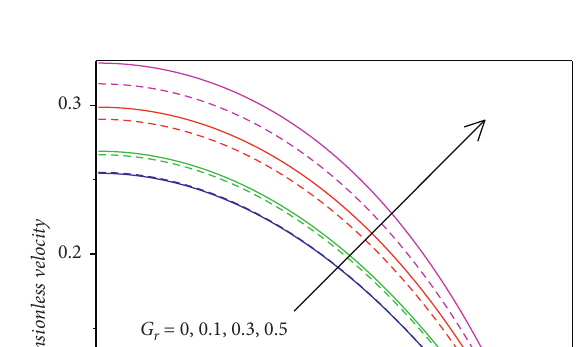
Figure 8: Behaviour of M